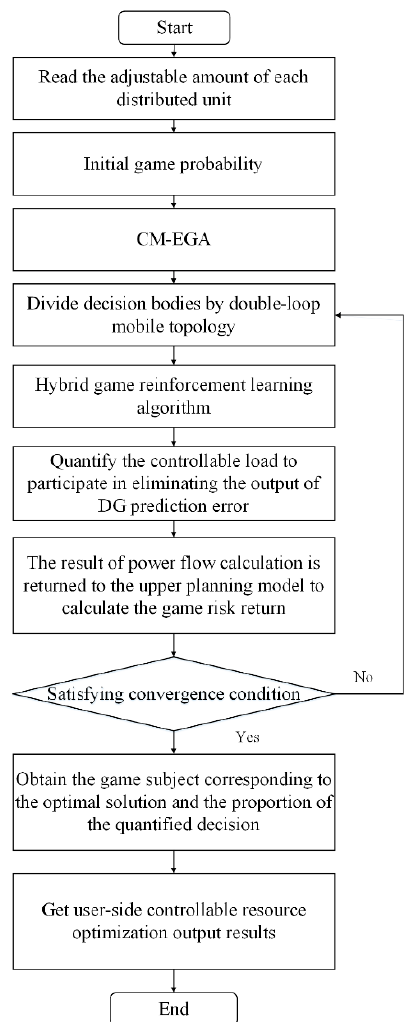
Figure 9. Bi-level optimization model flow chart.